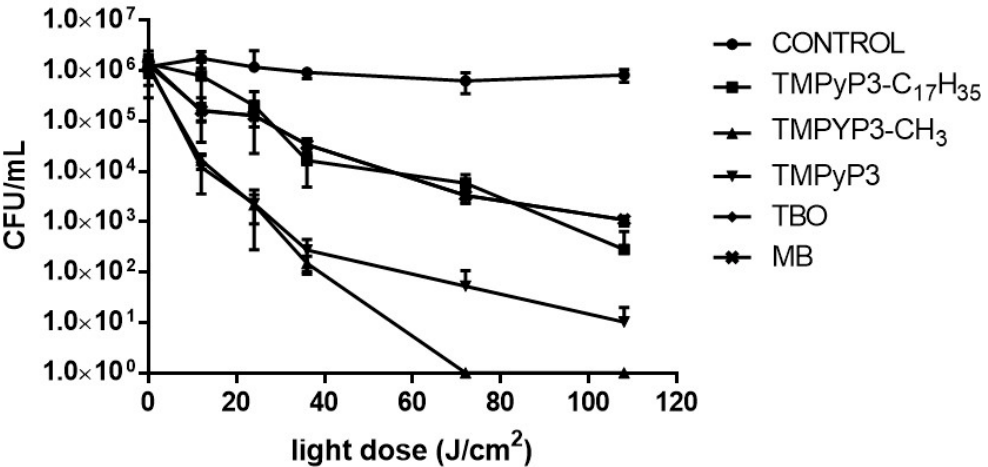
Figure 3. Photodynamic inactivation of L. pneumophila (CFU / mL) in the presence of 0.5 × MEC of photosensitizers (PSs) exposed to different doses of violet light ( λ = 394 nm; irradiance 20 mW·cm − 2 ). The control is L. pneumophila that was exposed to different light doses, without treatment with PSs. Data are given as the mean of 3 independent experiments ± standard deviation (SD).